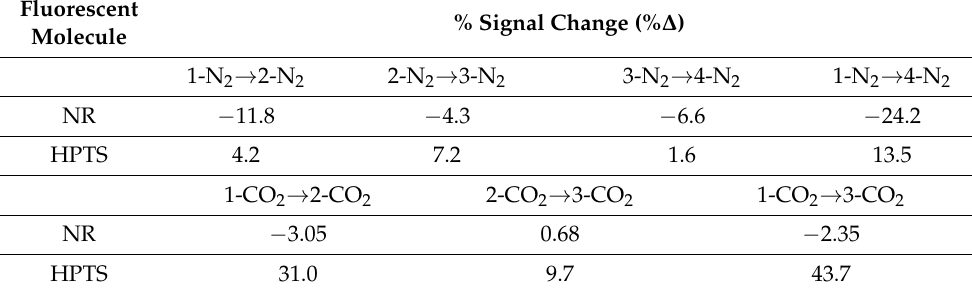
Table 4. Comparisons of drift between NR and HPTS showing the % signal change using the same dCO 2 concentration of two cycles, 0 mM (N 2 *) and 34.0 mM (CO 2 *). Comparisons were also made between the first cycle and the last cycle to show overall drift. Figure S4 contains complete fluorescence data.